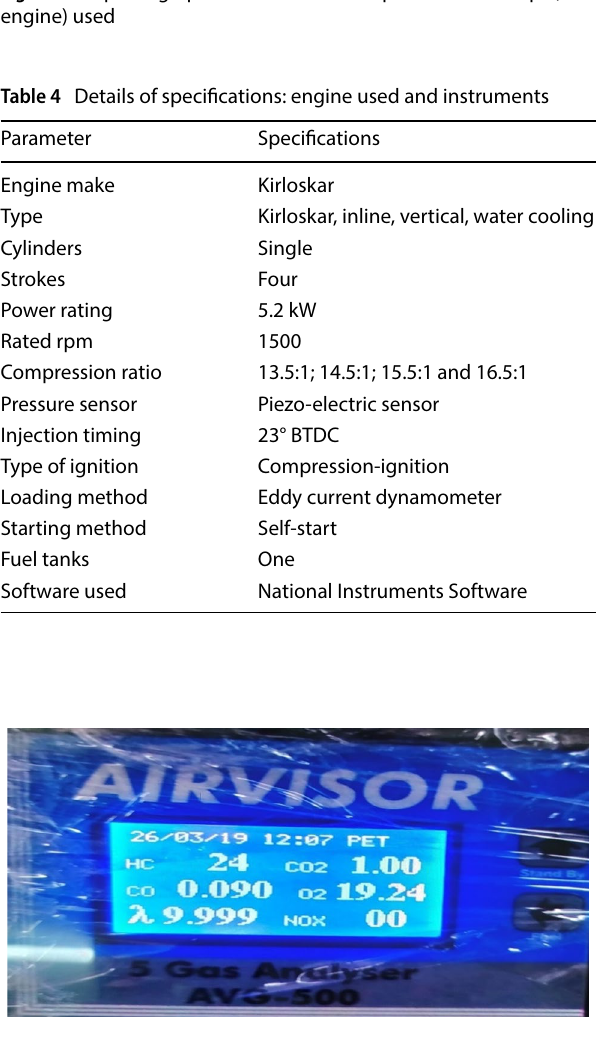
Fig. 4 Photographic view of the gas analyzer AVG-500